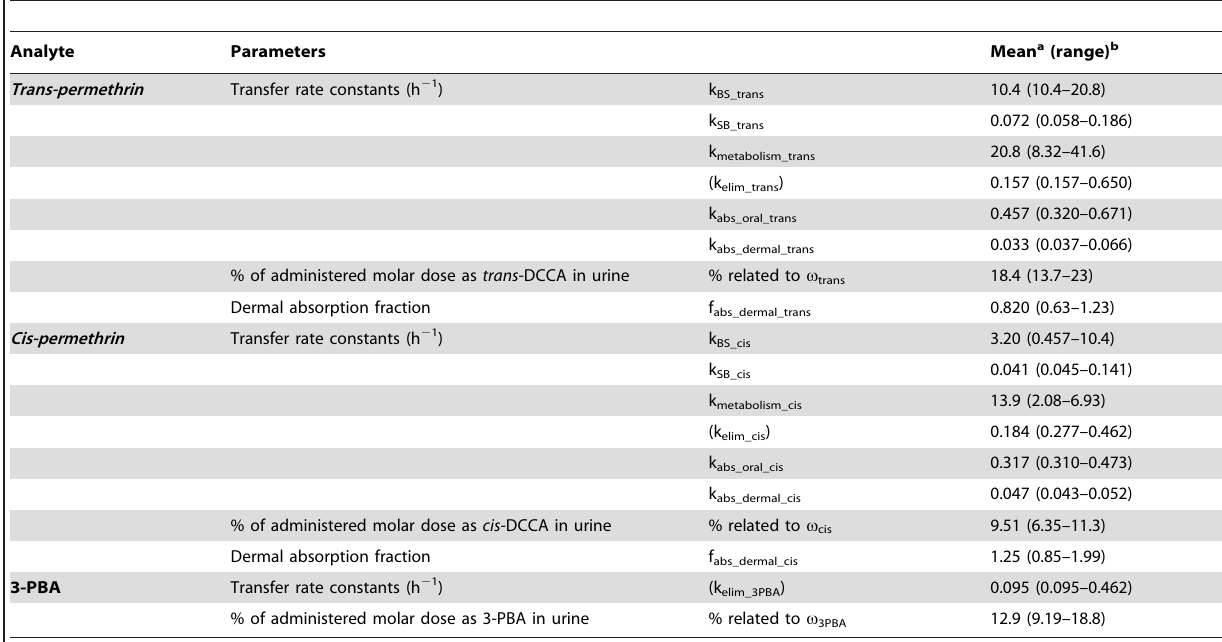
Table 2. Parameter values of the model based on fits to the data of Woollen et al. (1992) on both average and individual urinary excretion time courses of trans -DCCA, cis -DCCA and 3-PBA following an oral and dermal exposure in